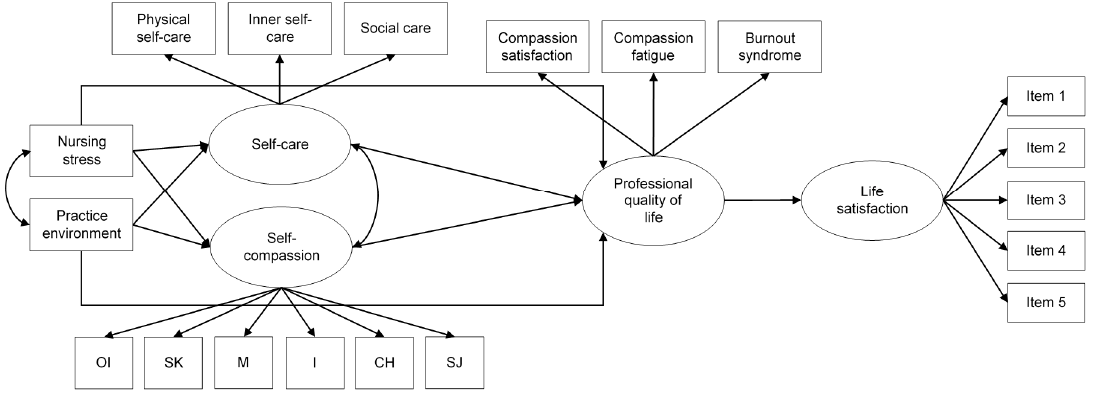
Figure 1. Hypothesized model. OI = over identification; SK = self-kindness; M = mindfulness; I = isolation; CH = common humanity; SJ = self-judgement.